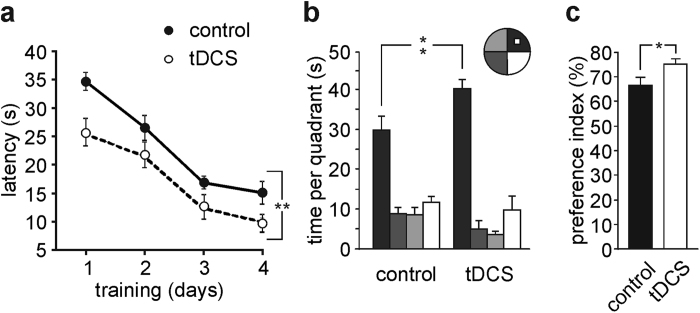
Anodal tDCS improves learning and memory in the MWM and NOR tests started 24 h after stimulation.(a) Escape latency to reach the hidden platform of control and anodal tDCS-mice (n = 9 for each group; F1,48 = 21.2, P < 0.001 for overall acquisition; main effect of days: F3,48 = 37.8, P < 0.001, two-way RM ANOVA). (b) Time spent in the four quadrants during probe test performed on day 5 of MWM test. In particular, tDCS-mice displayed a significant increase in the time spent in the target quadrant (black bars) compared to control animals (40.6 ± 3.0 s vs. 30.3 ± 3.3 s, P < 0.001; F3,48 = 4.7, P = 0.006 for interaction between tDCS and time in quadrants; two-way RM ANOVA, Bonferroni post-hoc). (c) Preference toward the novel object in NOR paradigm (n = 9 for each group; P = 0.04, unpaired Student’s t-test). Data are expressed as mean ± s.e.m. *P < 0.05; **P < 0.001.